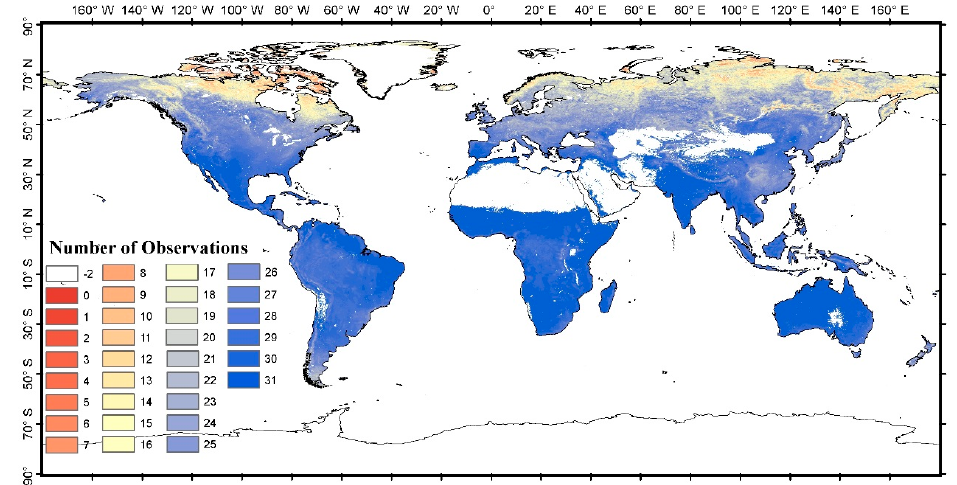
Figure 11. Average number of observations per month in the time series. The number of observations shows the number of good observations (without “no data values” or reflectance equal to or higher than 90%).